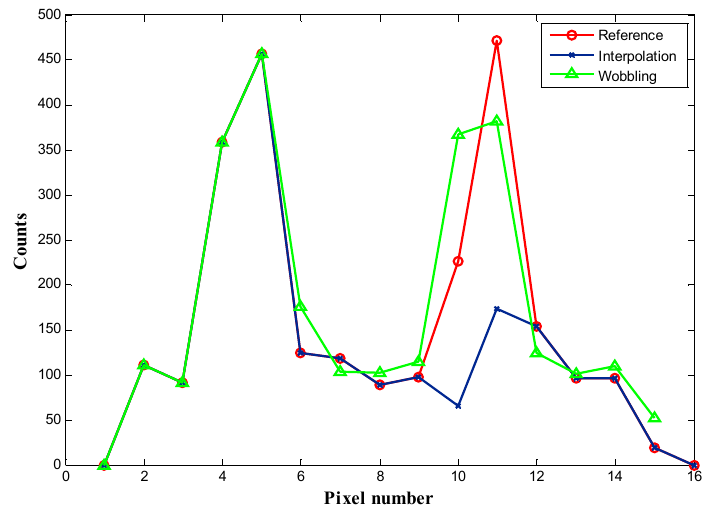
Figure 8. The pixel counts across row 8th of the corrected images. The blue line indicates the pixel counts after conventional interpolation and the green line indicates the counts after the proposed wobbling method is applied. The red line is the counts of the reference image.